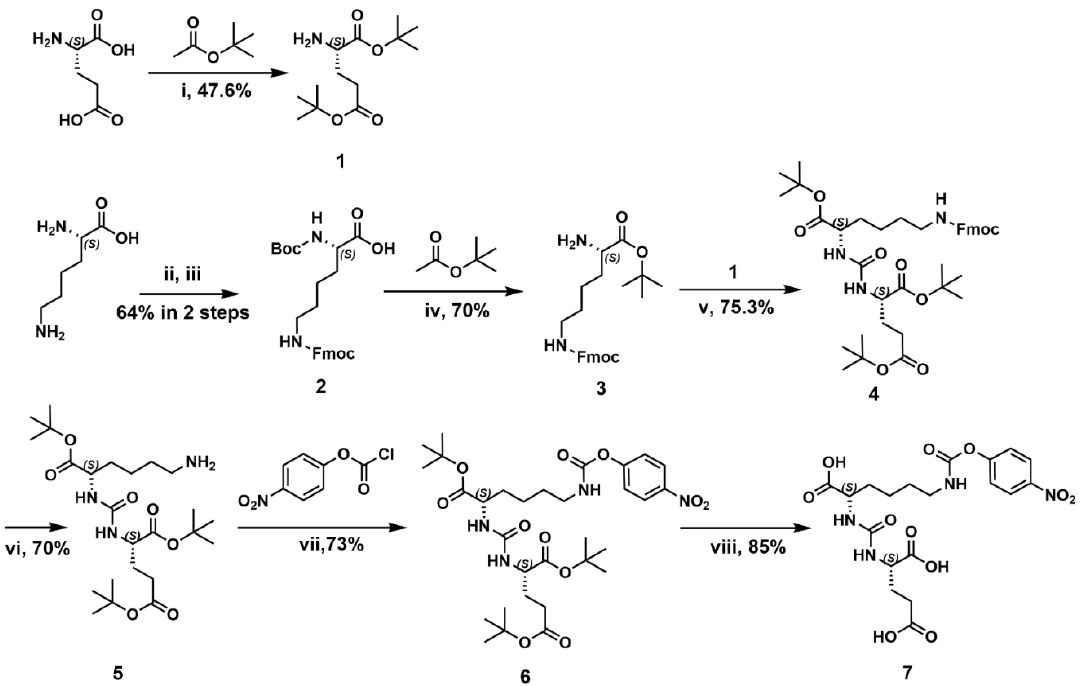
Scheme 1. The synthesis of PSMA-1. Reagents and conditions: (i) 70% HClO 4 , 47.6%; (ii)